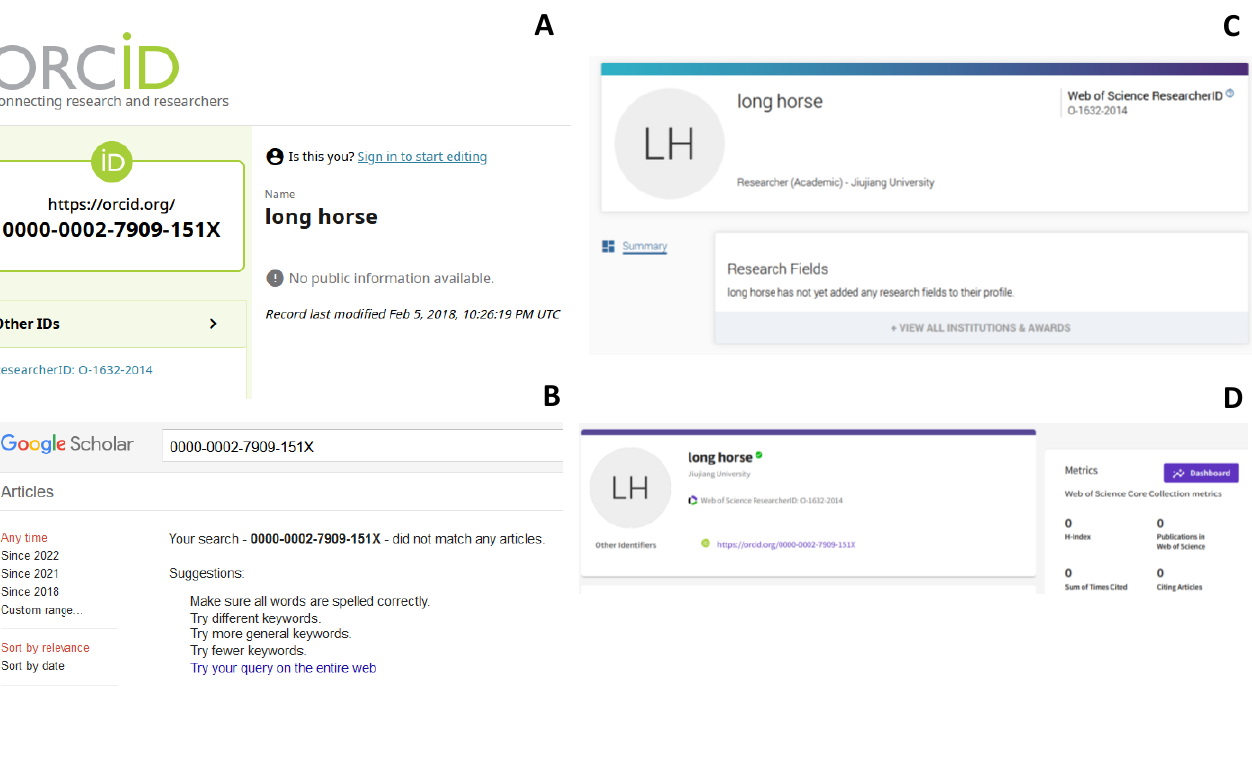
Figure 1. ORCID and ResearcherID of a “researcher” named “long horse”. (A) ORCID. (B) No academic papers associated with this ORCID on Google Scholar. (C) “long horse” aso had a Publons account. Screenshots: (A) https://orcid.org/0000- 0002-7909-151X; (C) Now defunct Publons account: https://publons.com/researcher/2465659/long-horse/; (D) Current Web of Science account. Screenshot dates: January 2, 2022 (A, B, C); September 26, 2022